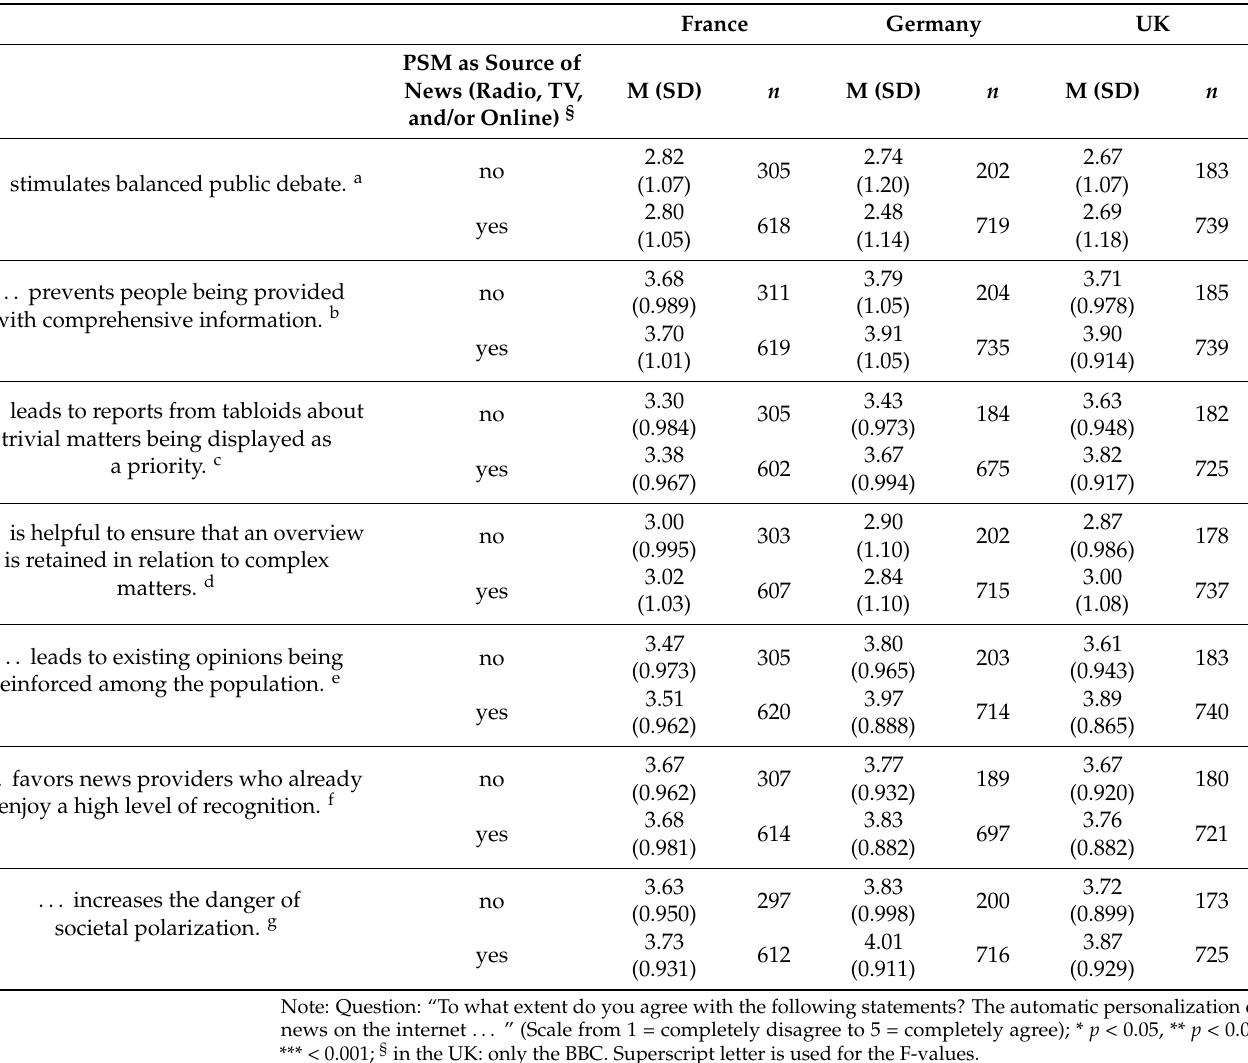
Table 2. Opportunities and risks associated with automated news personalization. France